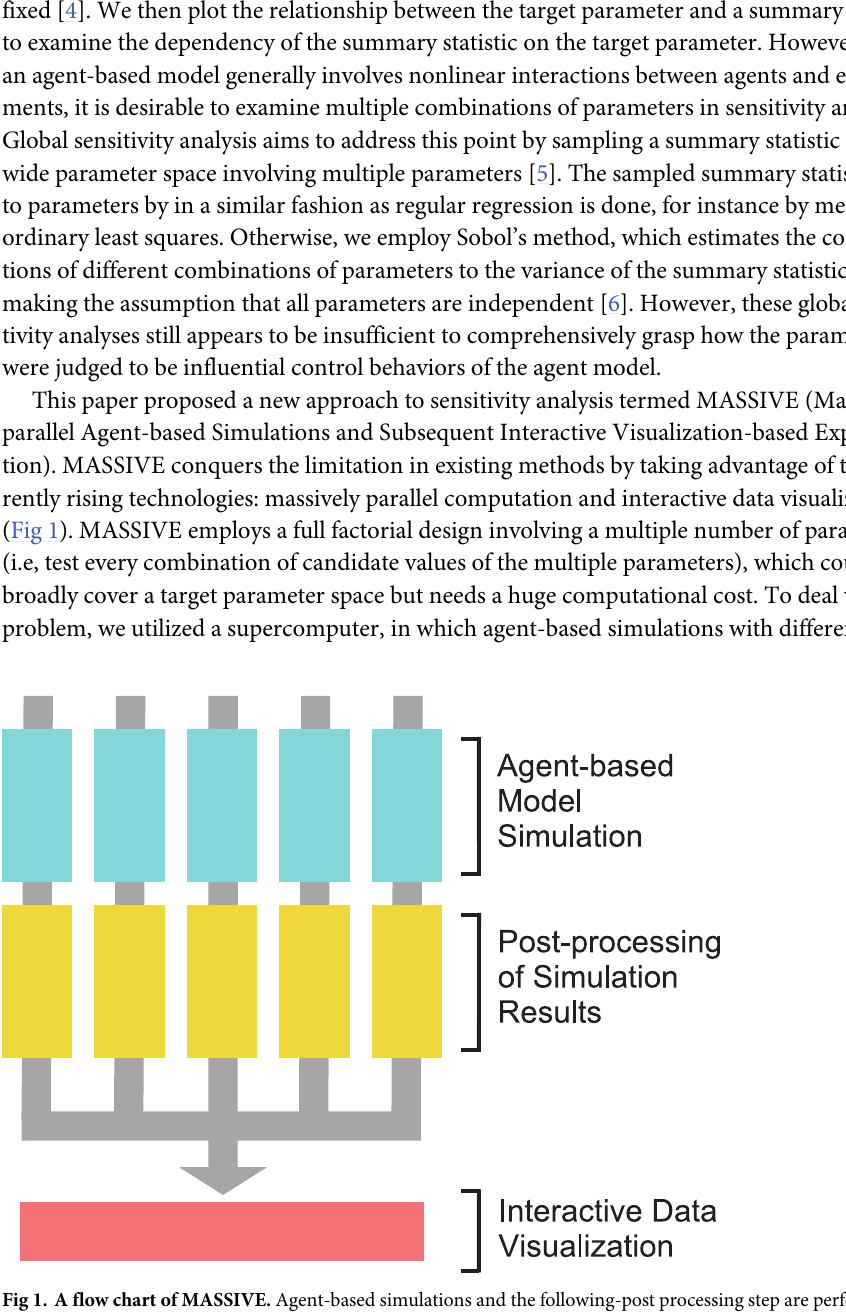
PLOS ONE | https://doi.org/10.1371/journal.pone.0210678 March 5,